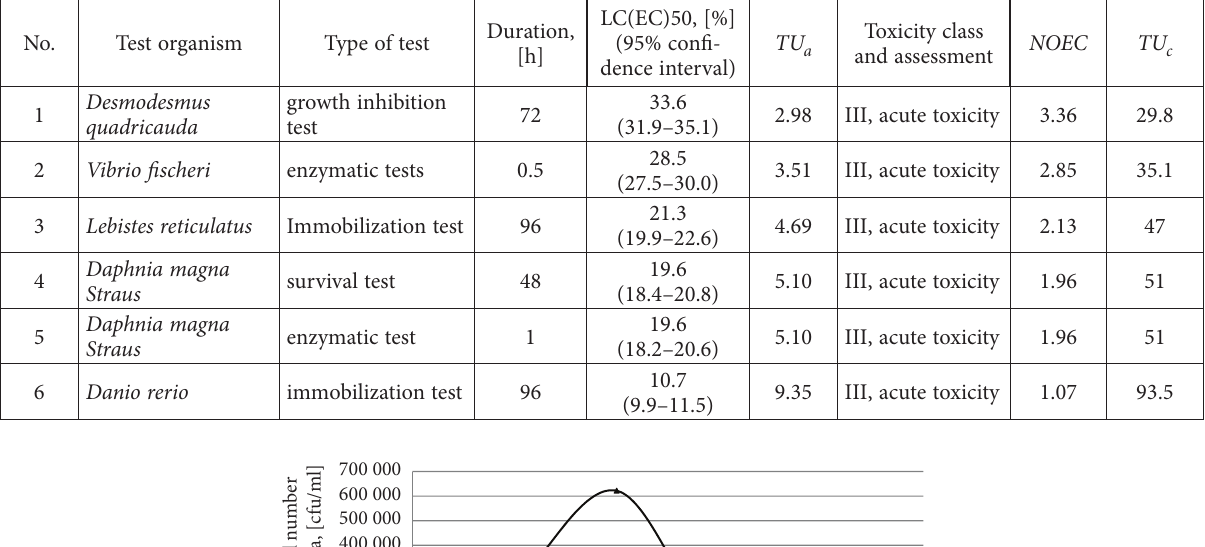
Table 1. Results of single-species bioassays and toxicity assessment of wastewater No.